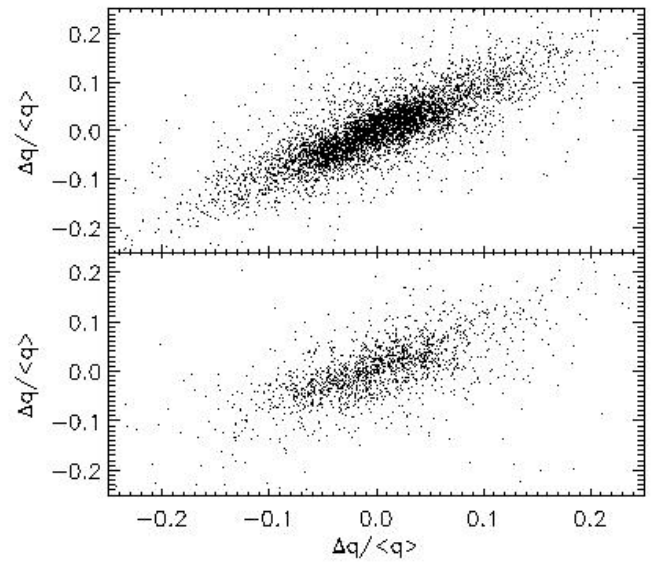
Figure 5. Daily residuals, which are the relative differences with respect to the annual average (for each group of days), for successive working